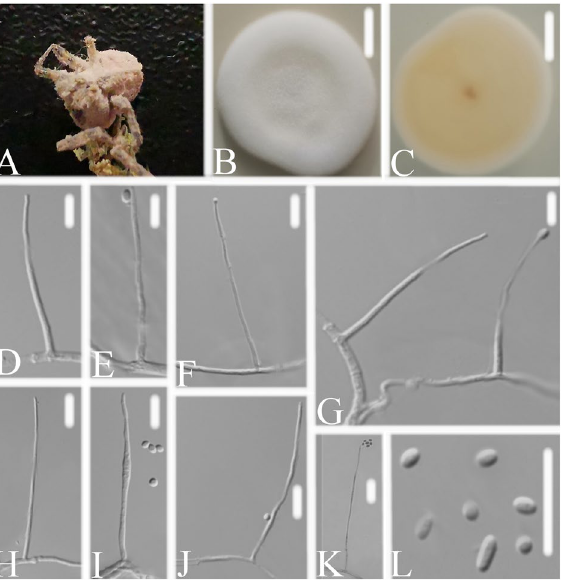
Figure 3. Simplicillium coccinellidae (A) infected ladybug (Coccinellidae) (B,C) culture plate, showing the front (B) and the reverse (C) of the colony, cultured on PDA medium (D–K) phialides solitary, conidia adhering ellipsoidal slimy head and conidia L conidia. Scale bars: 10 mm (B,C) , 10 μm (D–L) .